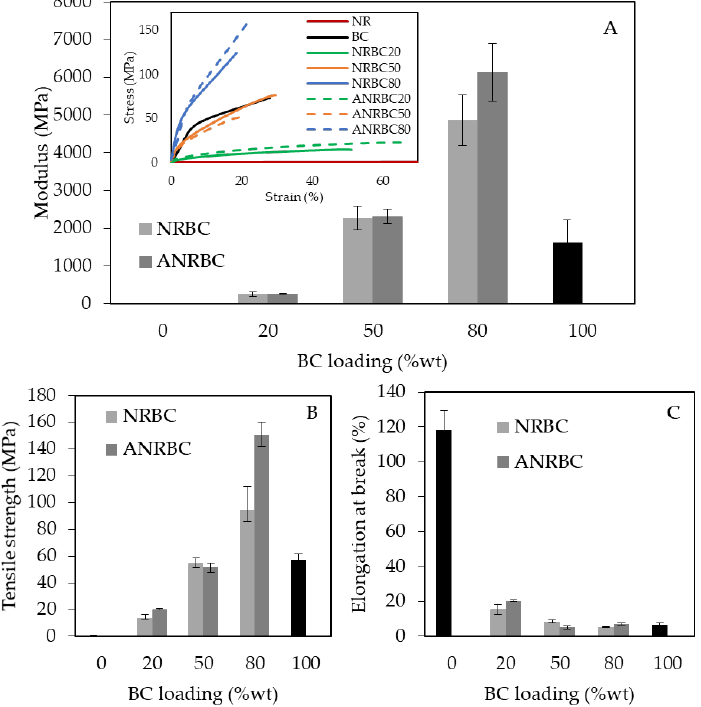
Figure 7. Mechanical properties, ( A ) Young’s modulus, ( B ) tensile strength and ( C ) elongation at break of NR, BC, NRBC, and ANRBC films. The values are expressed as mean ± SD (n = 5).